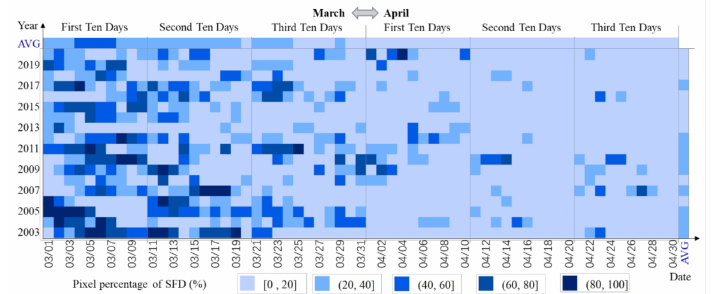
Figure 9. Time series risk of pixel-based spring frost damage (SFD) for tea plants from March 1 to April 30 in 2003–2020 in the middle and lower reaches of the Yangtze River region, China. The average pixel-based percentages of spring frost damage at annual and daily scales are also shown in the rightmost column and topmost row,